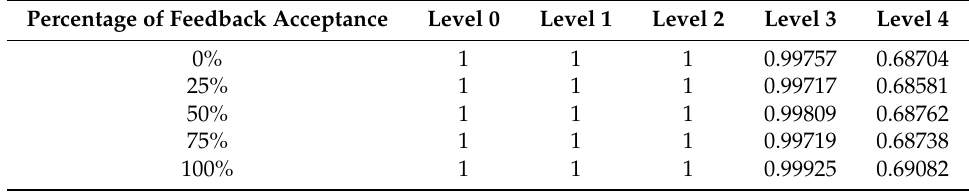
Table 11. User trust levels concerning autonomy when there is a high error rate at level 3 and the user is